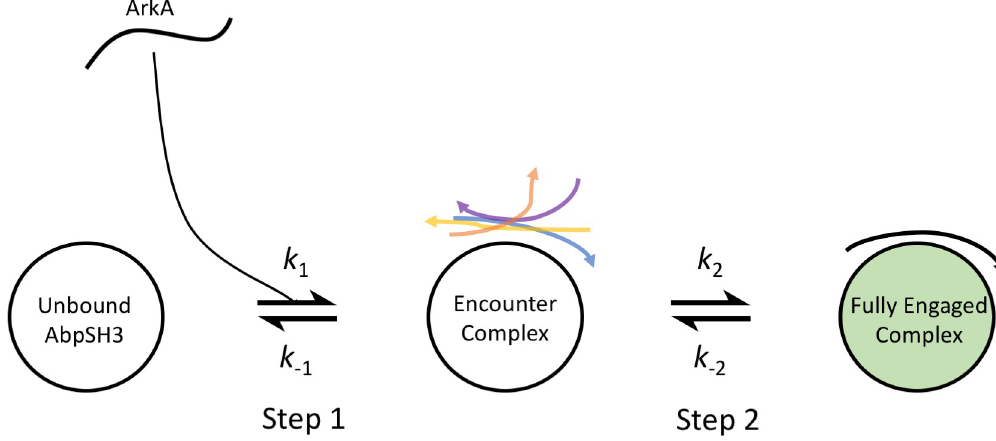
Fig 2. Proposed ArkA-AbpSH3 binding model. Two-step binding pathway with ArkA shown as a line and AbpSH3 as a circle. The heterogeneous encounter complex is proposed as an intermediate state between the unbound state and fully engaged complex. The forward and reverse rate constants for each step are